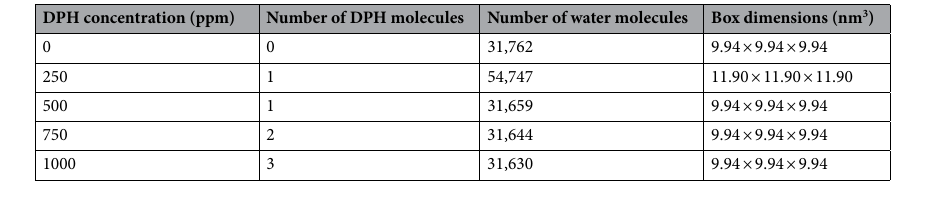
Table 1. The components of the simulation